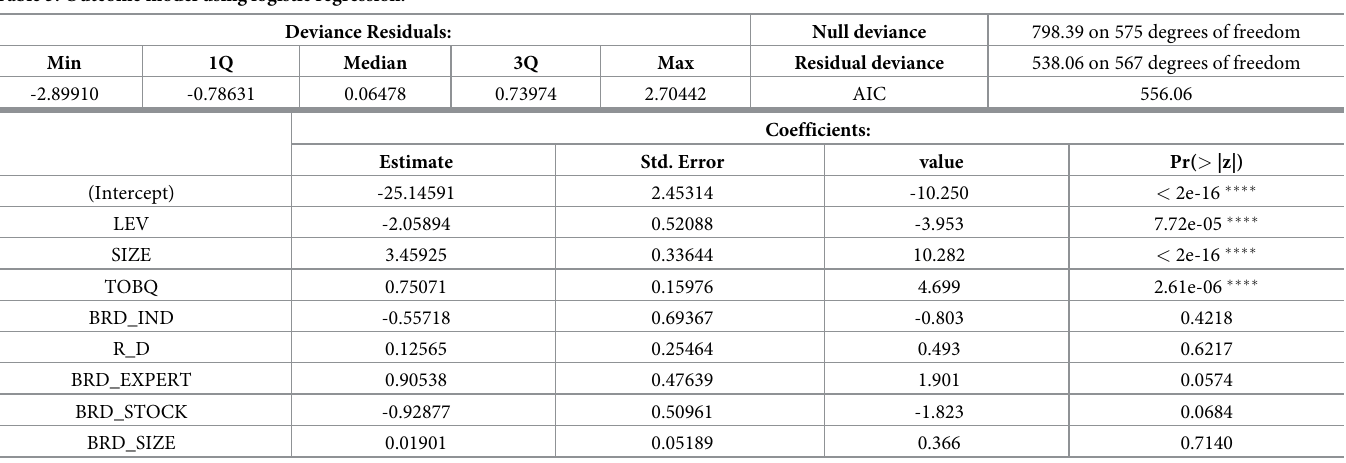
Table 5. Outcome model using logistic regression.